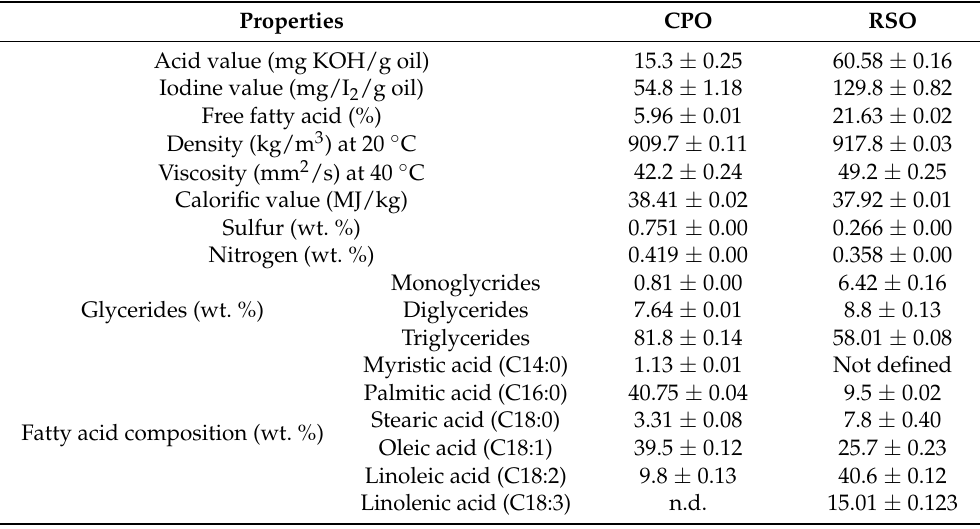
Table 2. Crude oil properties of rubber seed (RSO) and palm